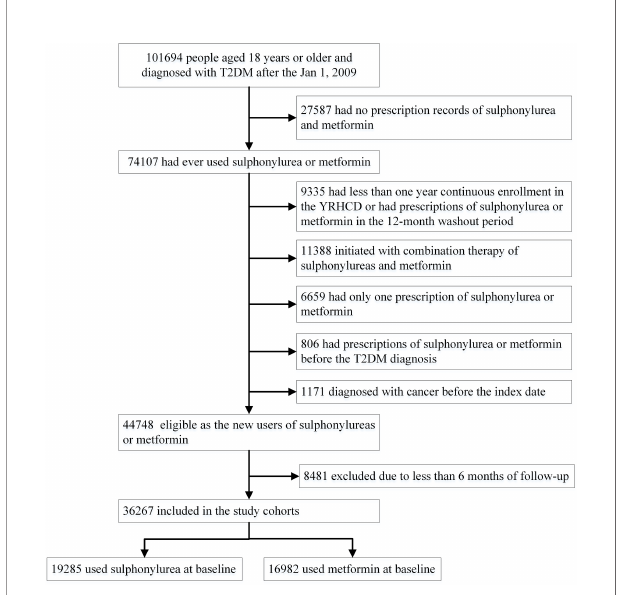
FIGURE 1 | Flowchart of participants in the study cohorts. T2DM, type 2 diabetes